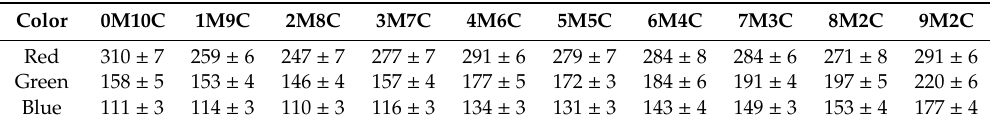
Table 5. Red, Green and Blue coordinates of the color of the different families of samples conformed with clay and mining waste.